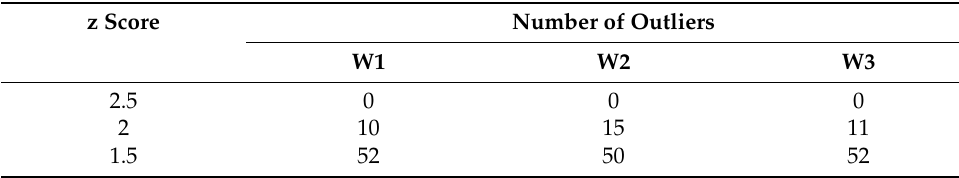
Table 3. Number of outliers versus